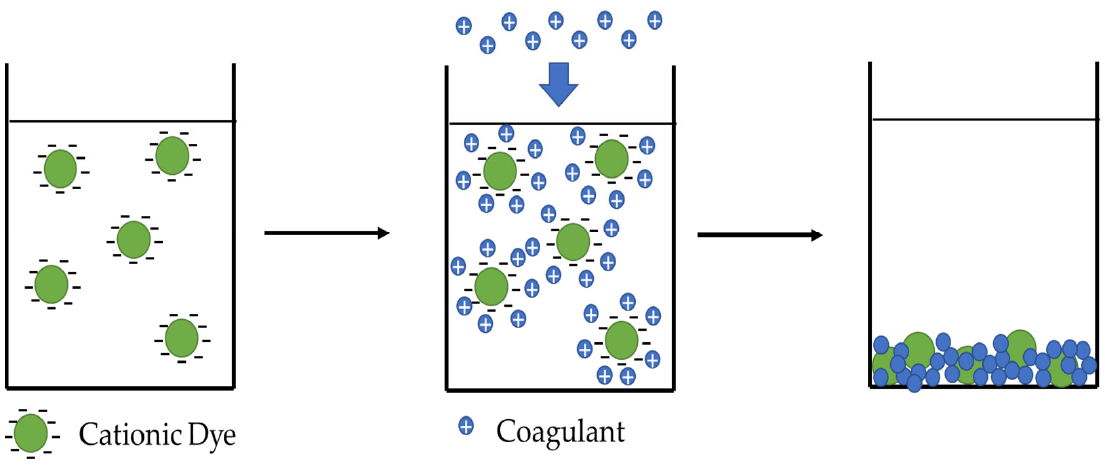
Figure 4. Illustration of coagulation of wastewater dyes by coagulants.